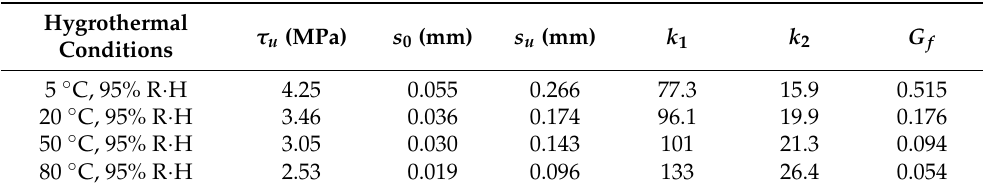
Table 1. Major bond parameters for bond–slip relationship with different hygrothermal pretreatments (data from [37]).